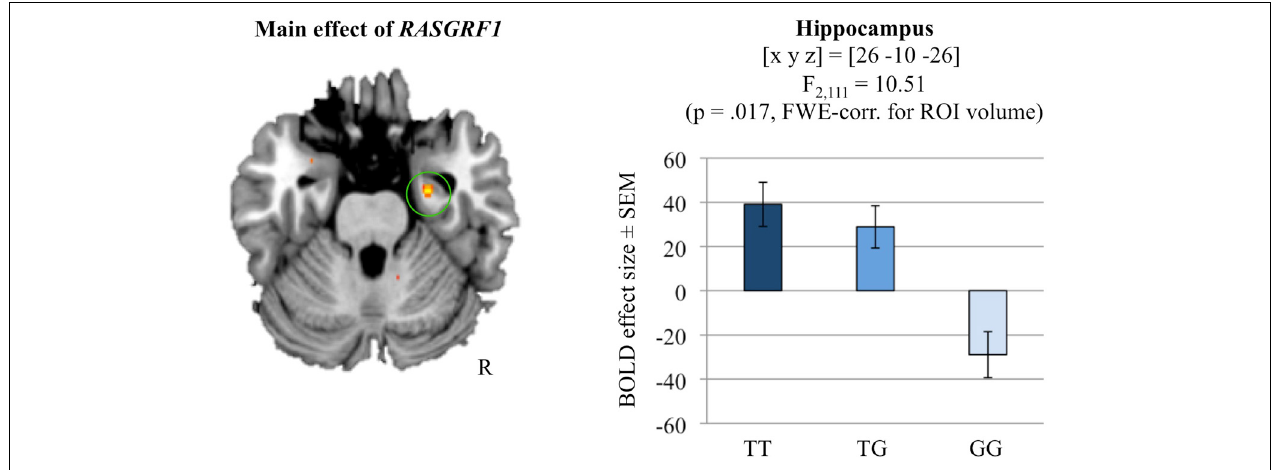
FIGURE 3 | Hippocampal novelty processing and its modulation by RASGRF1 genotype (main effect of RASGRF1 ). TT carriers exhibited increased hippocampal activation, when compared to G allele carriers. This effect was significant at p < 0 . 017, FWE-corrected for ROI volume.